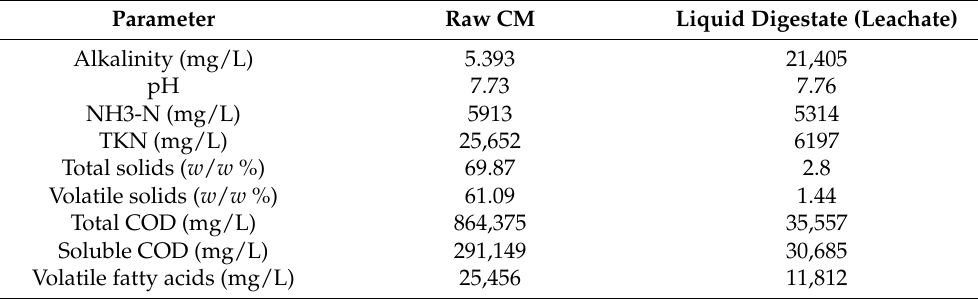
Table 1. Physicochemical characteristics of raw chicken manure (CM) and liquid digestate (leachate).